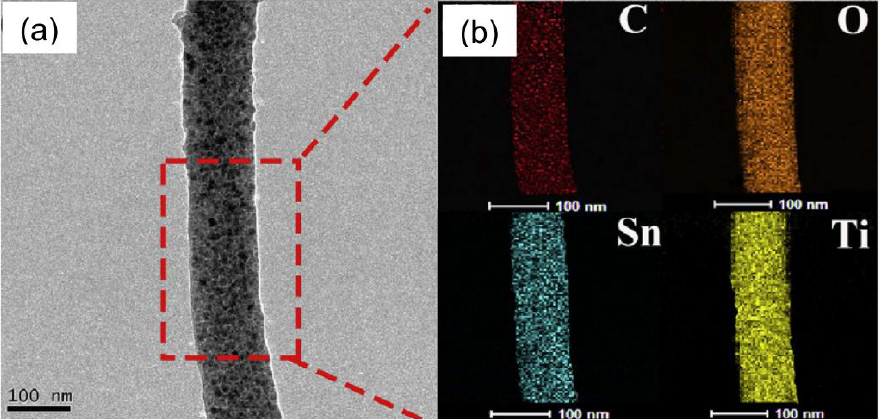
Figure 14. ( a ) TEM image of TiO 2 -Sn/C fibers and ( b ) elemental dispersion maps of fiber components (reproduced from reference [137] with permission. Copyright 2018, Elsevier).